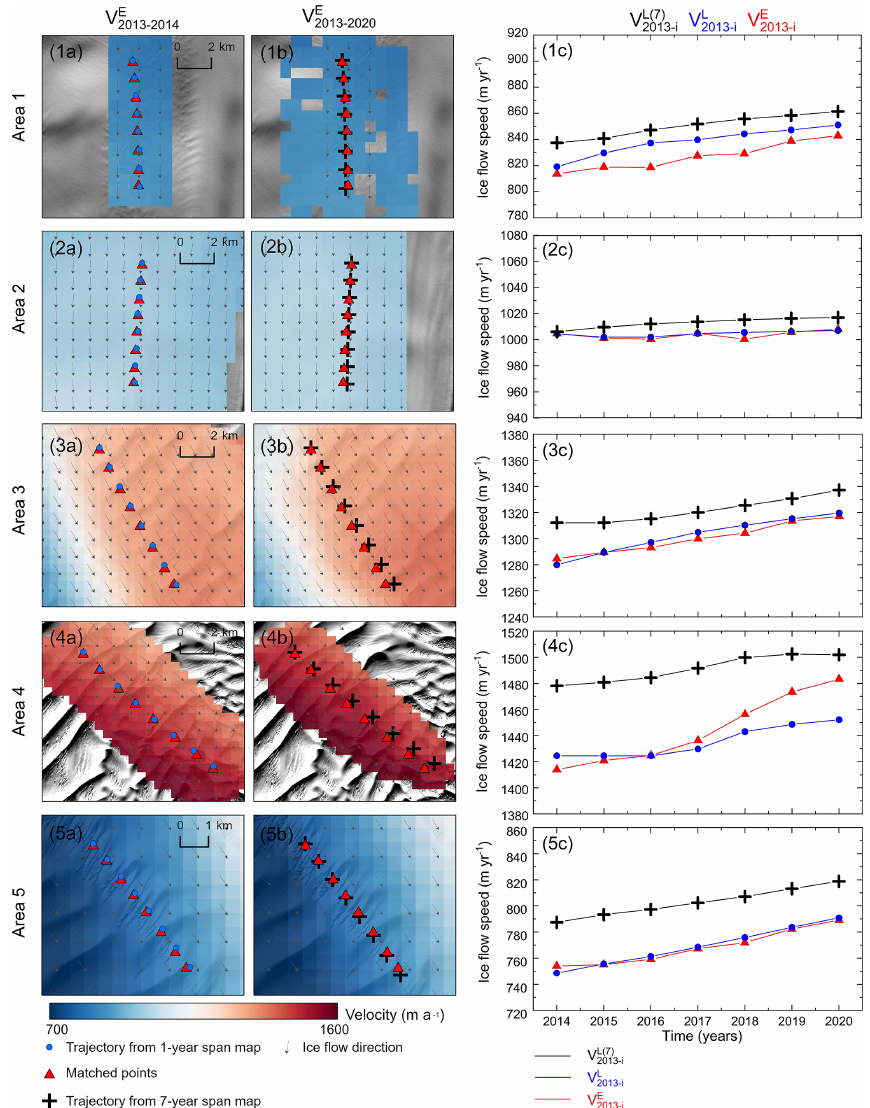
Figure 5. Velocities in five areas (rectangles in Fig. 4) of the Totten Glacier are used to validate Premises I and II. Panels (1a) – (5a) show the reconstructed 1-year velocity maps V 2013–2014 in the areas; matched points (red triangles) are used to map E velocity V E ( i = 2014, ... , 2013– i 2020) (red lines in panels 1c – 5c ); points along the flow line (blue dots) are tracked from the 1-year maps and used to calculate L velocity V L (blue lines in panels 1c – 5c ). Similarly, panels (1b) – (5b) illustrate the reconstructed 7-year velocity maps V 2013–2020 in the areas 2013– i with the matched points (red triangles) for E velocity V E( 7 ) ; points along the flow line (black crosses) are tracked from the 7-year-span 2013– i velocity map and used to calculate L velocity V L( 7 ) (black lines in panels 1c – 5c ). In each area (panels 1c – 5c ) the difference between 2013– i red and blue lines increases with time but is limited within kσ at the end (Premise I), except a large k in Area 4 because of the effect of a calving event; the black line is above the blue line due to the spatial-acceleration-induced OE over 7-year span, but they are relatively parallel (Premise II), and thus a correction can be